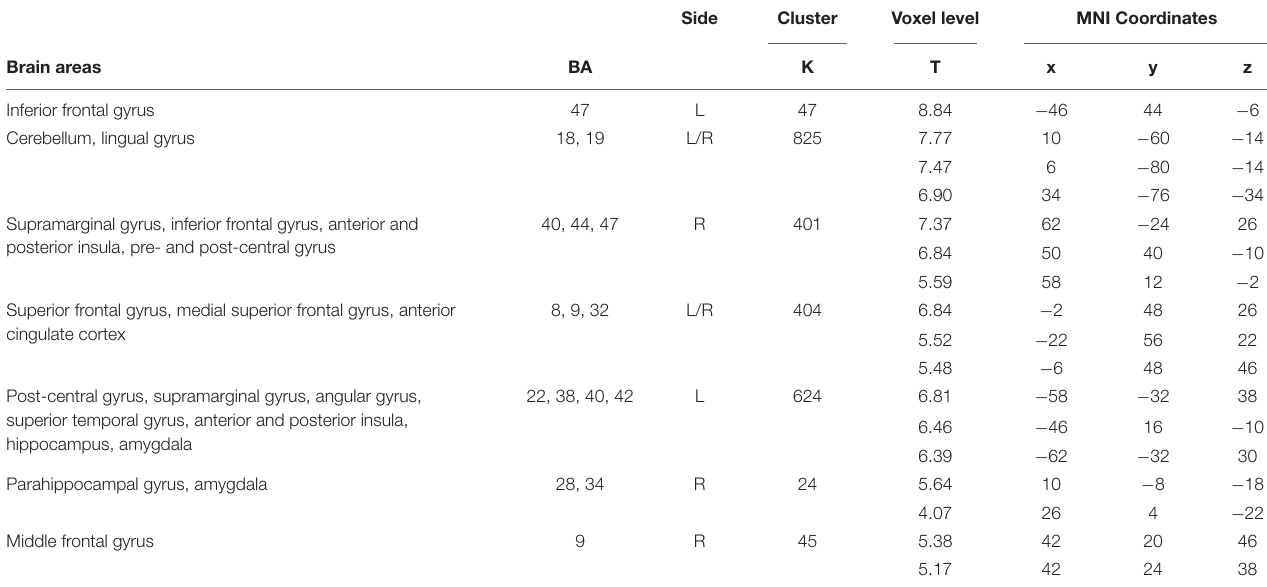
R, right; L, left; BA, Brodmann area.